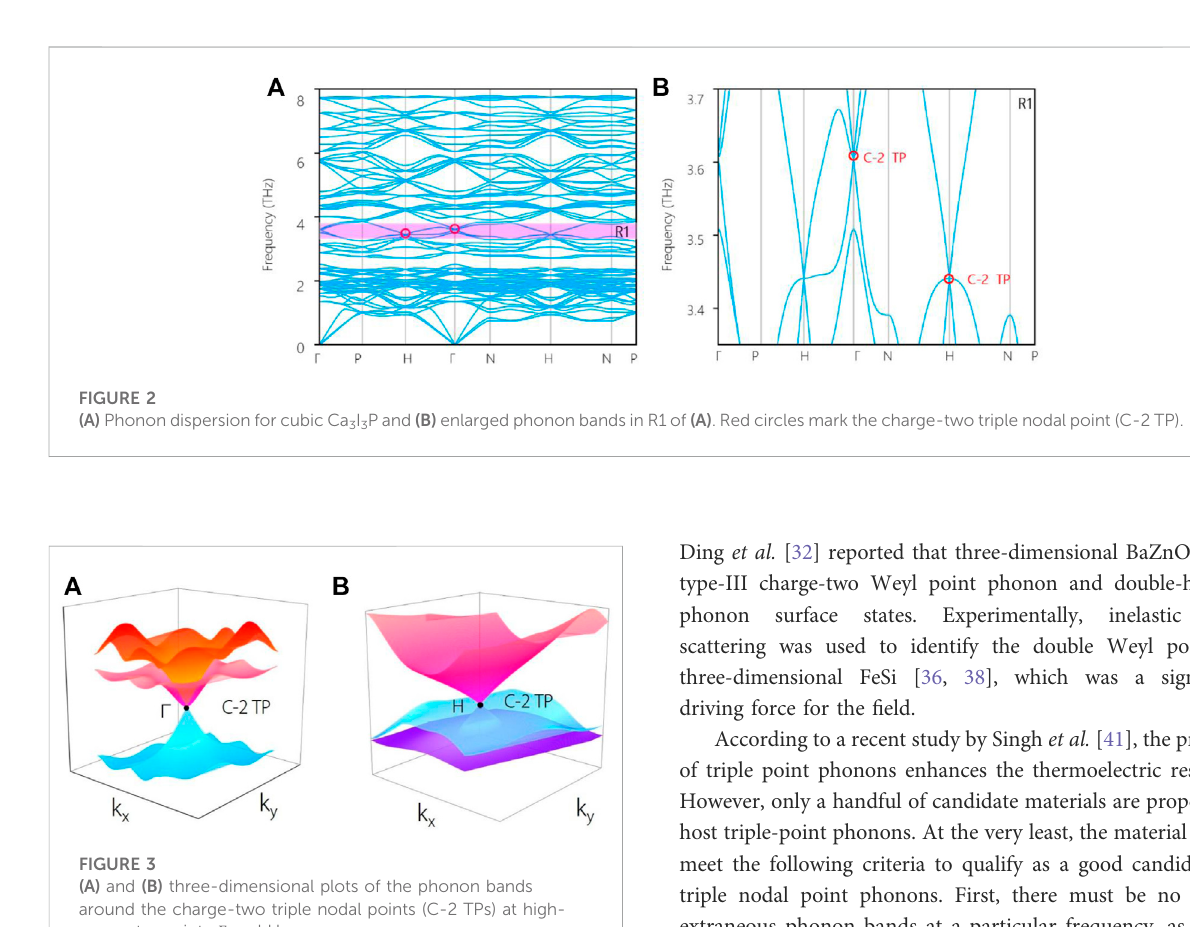
FIGURE 3 (A) and (B) three-dimensional plots of the phonon bands around the charge-two triple nodal points (C-2 TPs) at high- symmetry points Γ and